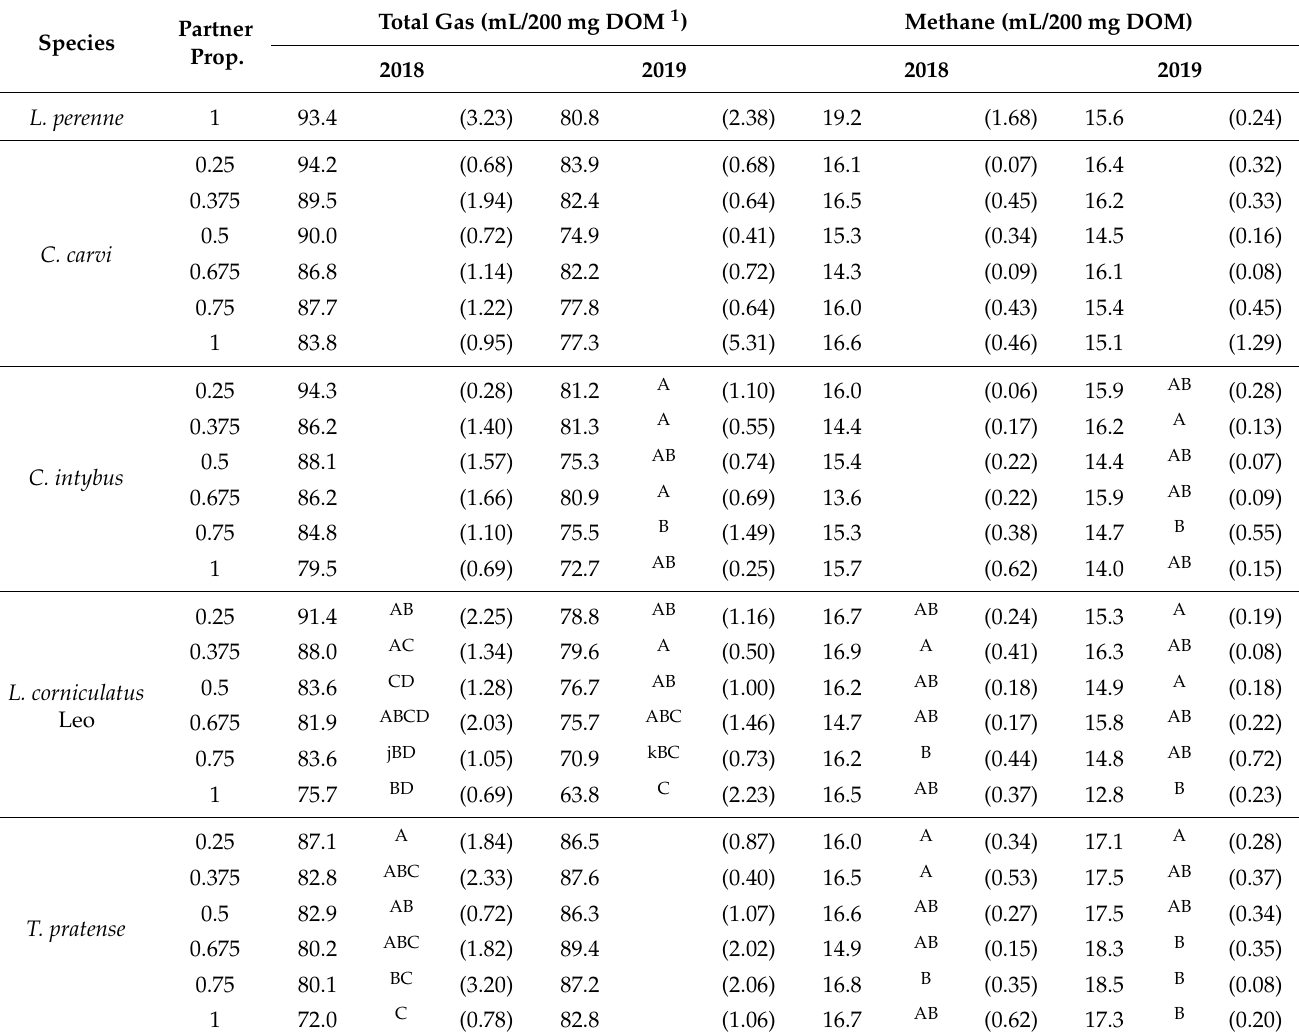
Table 4. Mean values of measured in vitro fermentation parameters in a 24 h incubation period of species harvested in 2018 and 2019 consecutively. Numbers between brackets correspond to the standard error of the mean (SEM). Partner Species